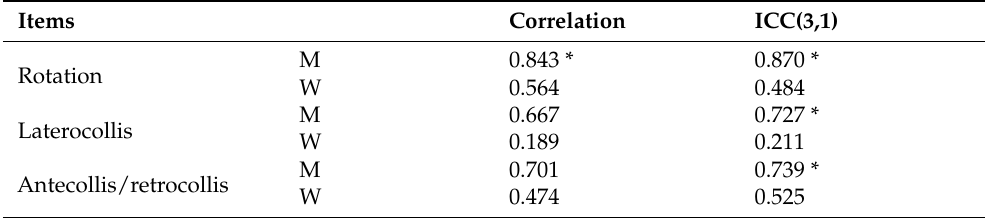
Table 4. Validity and accuracy of the multi-view based method and the wearable IMU based method. Items Rotation